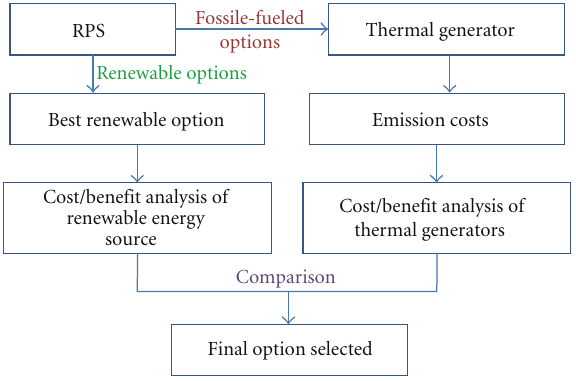
Figure 15: Selection between renewable and fossil fuel.